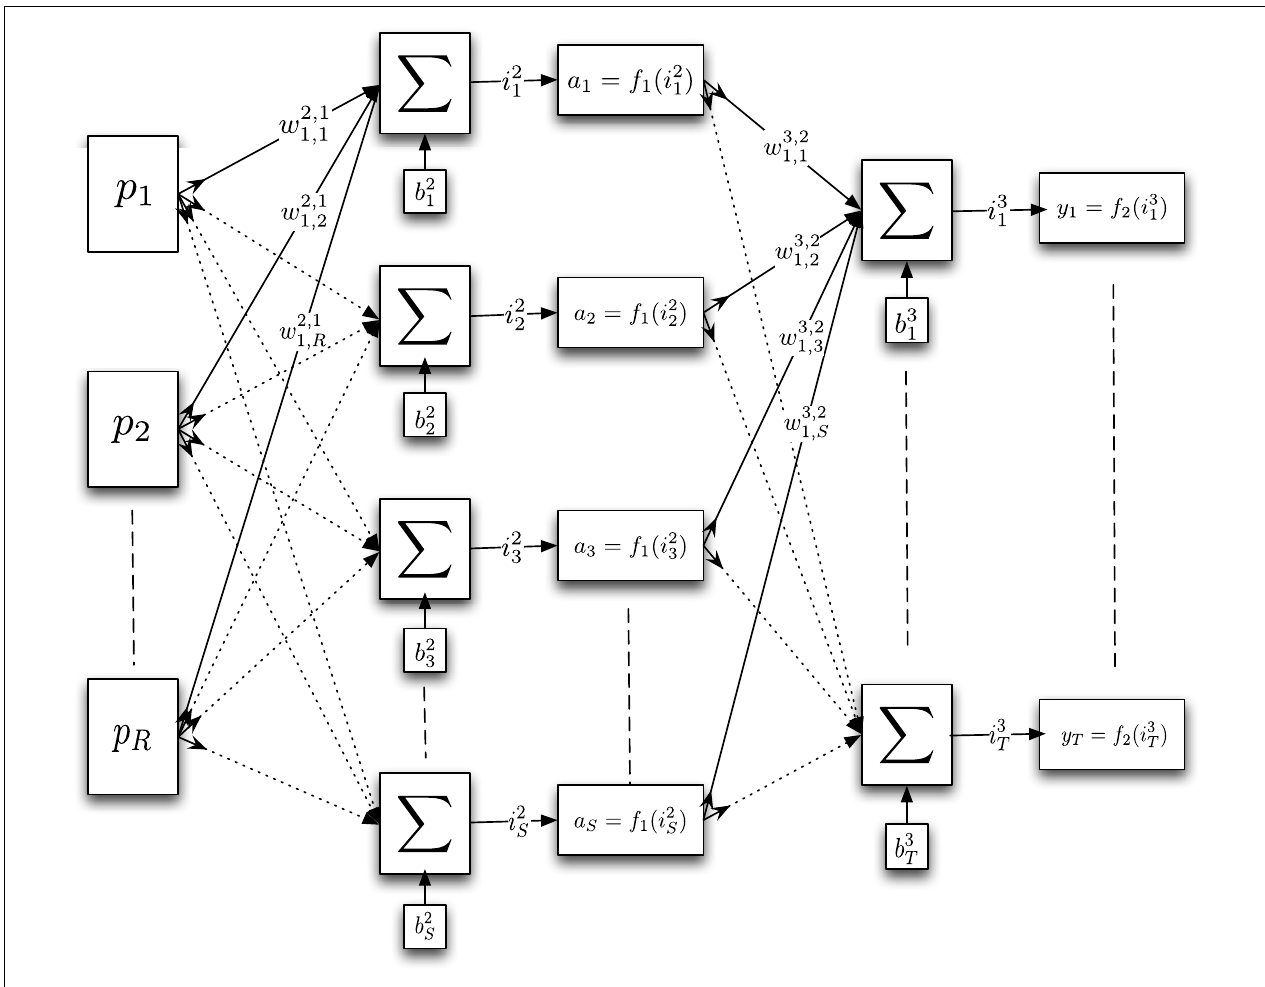
FIGURE A1 | Detailed structure and topology of feedforward neural